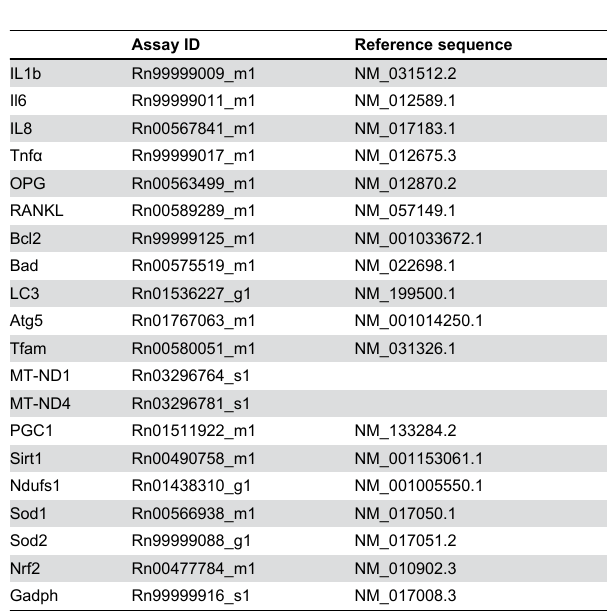
Table 2. Assay ID of probes used in TaqMan® Gene Expression Assays (Applied